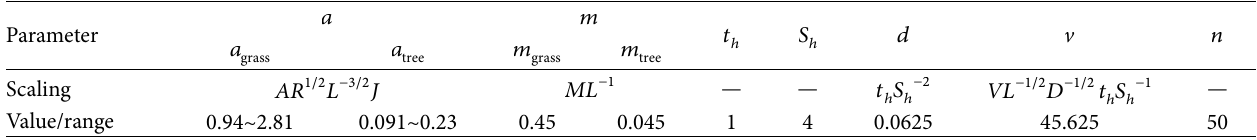
Table 2: Values/ranges and scaling for the parameters of the discrete